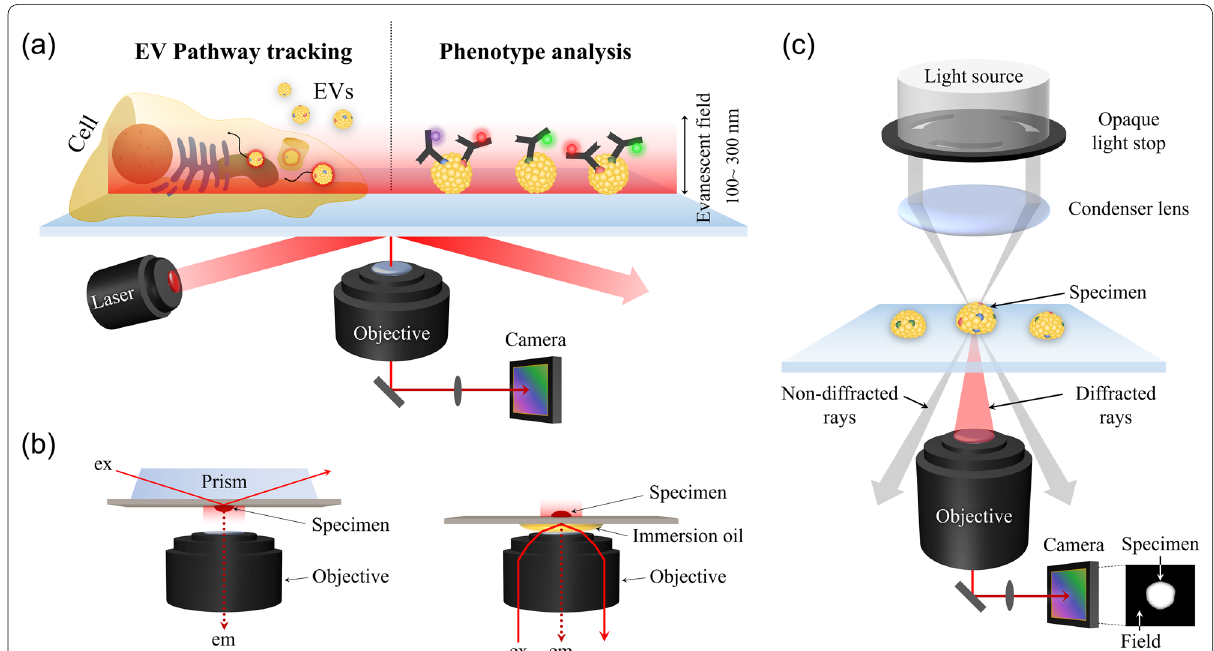
Fig. 3 Principle of optical microscopy techniques. a Single EV analysis types by total internal reflection fluorescence (TIRF) microscopy: intracellular EV pathway tracking, immobilized EV phenotype analysis. b Two types of TIRF microscopy (left: prism-type TIRF, right: objective-type TIRF). c Principle of detecting scattered ray of particles in a dark-field (DF) microscopy: the signal scattered by the particle is displayed brightly, while the transmitted signal is not detected, resulting in a dark